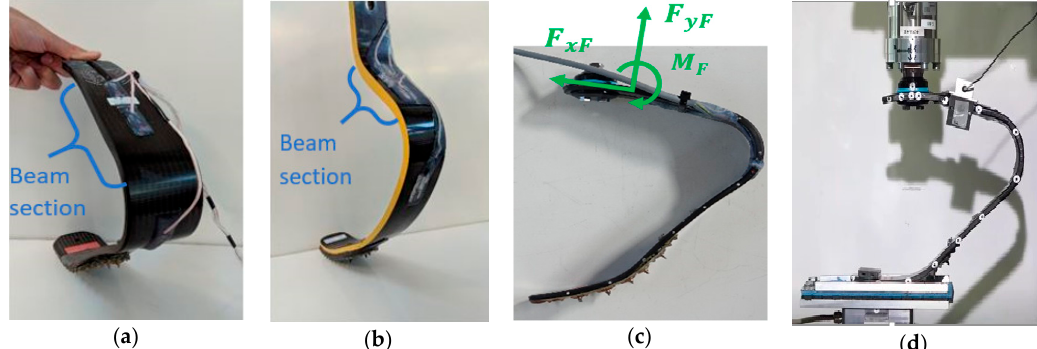
Figure 2. Development and calibration of the instrumented RPF: ( a ) Strain gauge bridges applied to a C shaped Ottobock Runner Cat3 RPF, ( b ) bridges applied to a J shaped Ossur Cheetah Xtreme cat5, ( c ) load components obtained by decoupled measurements at the iRPF reference point, ( d ) calibration of the iRPF on a multicomponent test bench [7].